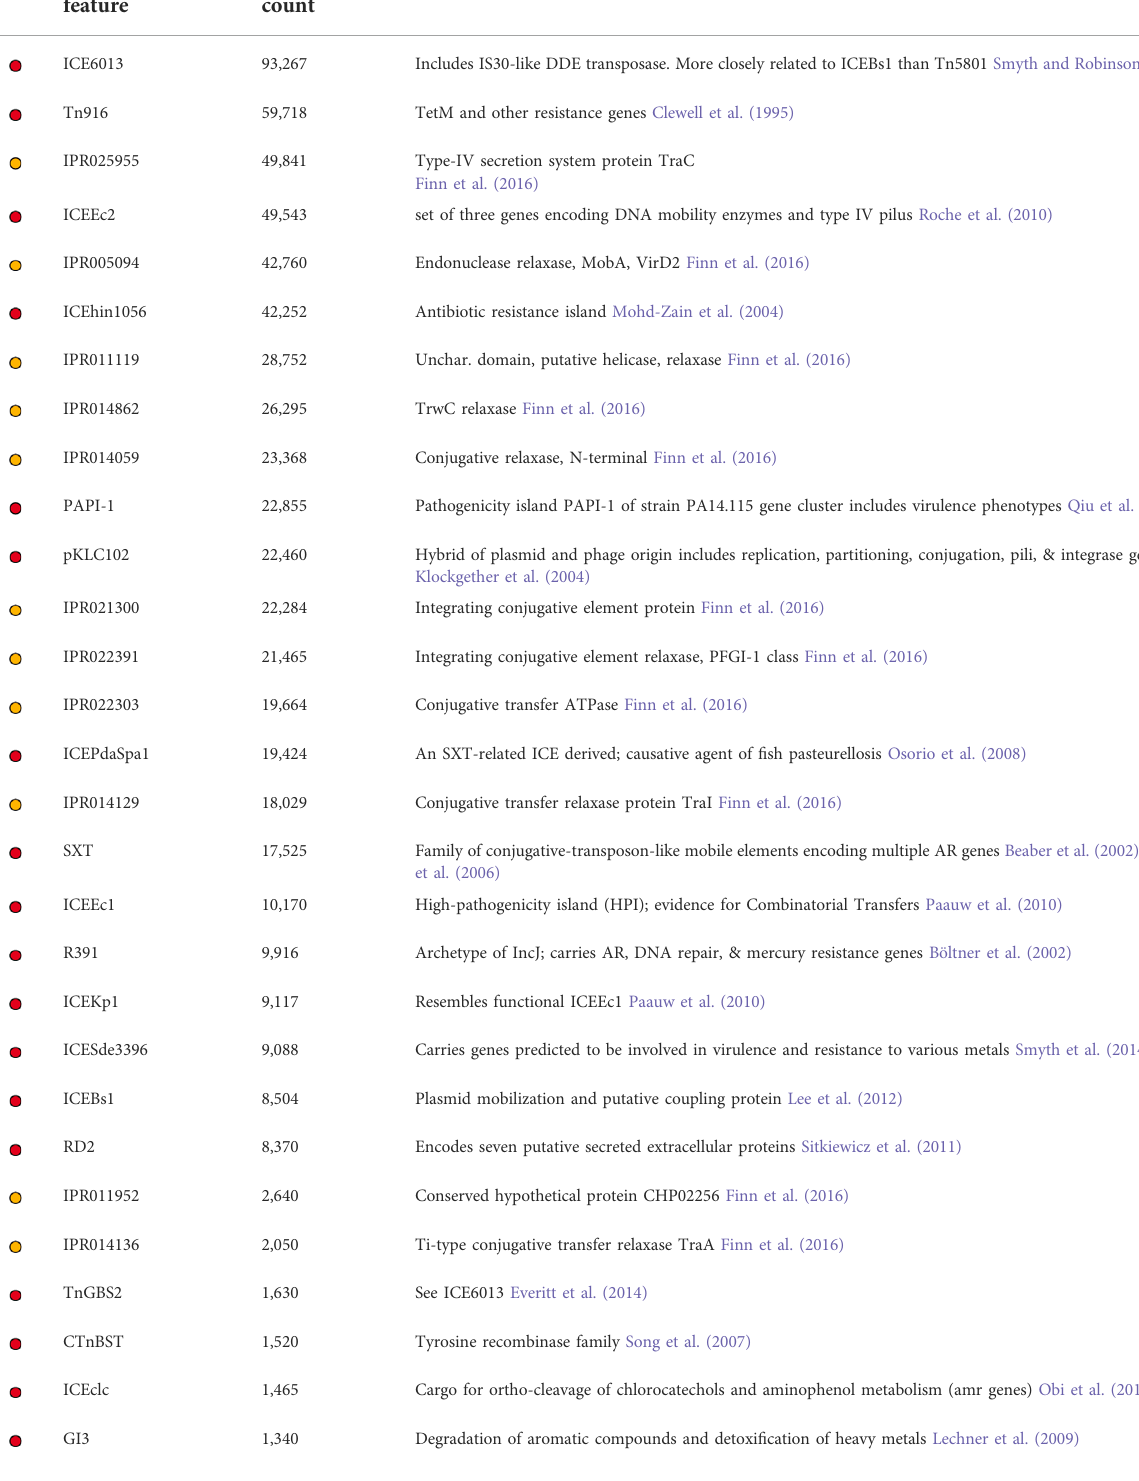
TABLE 1 Conjugative features included in this study. Color label indicates the color used to represent the conjugative feature in Figure 2. Yellow indicates a conjugativefeature de fi ned by asingle IPR codeand redindicatesa family of codes. Genomecount indicates the number ofgenomes that contain the conjugative